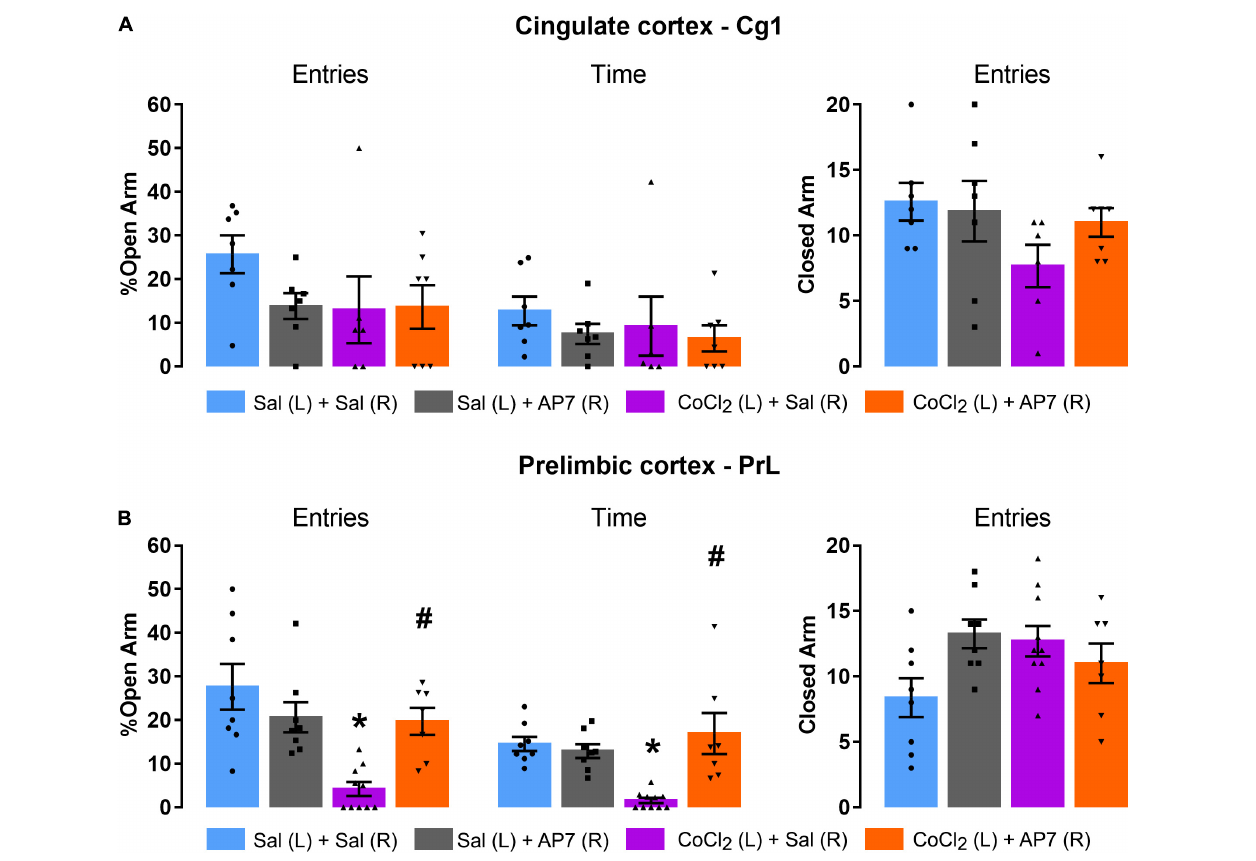
FIGURE 6 | Effects of AP7 injected into the right dorsal mPFC (R) subsequently to CoCl 2 injection into the left dorsal mPFC (L) on behavior of mice exposed to the EPM. (A) Cg1 analysis on the percentage of open-arm entries and time, and frequency of closed-arm entries [Sal (L) + Sal (R) ( n = 7); Sal (L) + AP7 (R) ( n = 7); CoCl 2 (L) + Sal (R) ( n = 6); CoCl 2 (L) + AP7 (R) ( n = 7)]. (B) PrL analysis of the percentage of open-arm entries and percentage of open-arm time, and frequency of closed-arm entries [Sal (L) + Sal (R) ( n = 8); Sal (L) + AP7 (R) ( n = 8); CoCl 2 (L) + Sal (R) ( n = 10); CoCl 2 (L) + AP7 (R) ( n = 7)]. Bars with scatter dot plot represent mean ( ± SEM). * p < 0.05 compared with Sal (L) + Sal (R) group; # p < 0.05 compared with CoCl 2 (L) + Sal (R) group. L, left; R, right; Sal, saline; AP7, 2-amino-7-phosphonoheptanoic acid—an NMDA glutamate receptor antagonist; CoCl 2 , cobalt chloride.